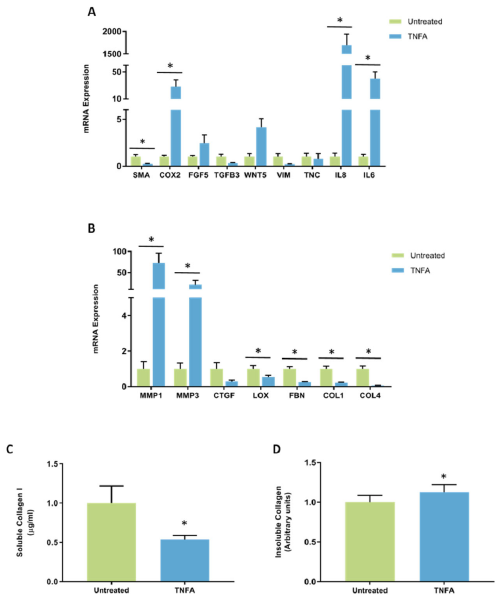
Figure 10. The effect of TNFA on mRNA expression and collagen production in mammary fibroblasts. Messenger RNA expression of cancer-associated genes ( A ) and genes involved in extracellular matrix regulation and collagen production ( B ) measured by RT-PCR in human mammary fibroblasts following treatment with 10 ng/mL of TNFA for 72 h. mRNA expression normalised to HPRT1 expression and presented as relative expression where the average for untreated control is 1. Collagen production was measured using collagen 1 ELISA ( C ) and insoluble collagen measured by sirius red staining ( D ). Data presented as mean + SEM with statistical analysis performed using a linear mixed- effects model Tukey’s post hoc comparison. Statistical significance indicated by * when p <